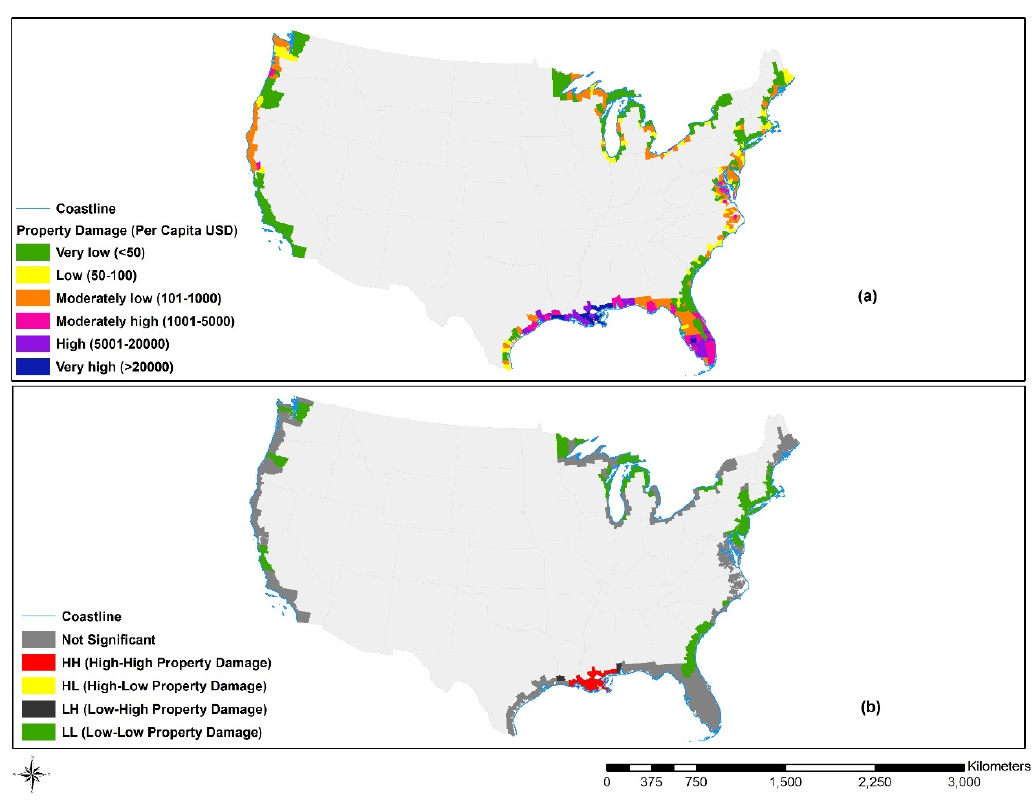
Figure 4. The spatial distribution of ( a ) property damage values and ( b ) clusters of hot and cold spots of property damage in the study area.